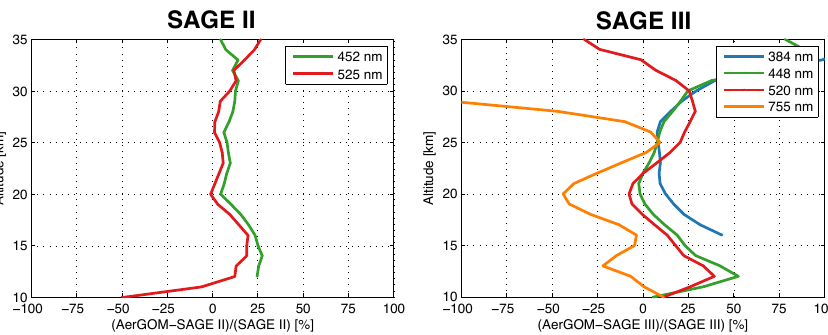
Figure 5. Relative difference of aerosol extinction comparisons between a modified AerGOM dataset using a different spectral law (poly- nomial of degree 1 in λ − 1 ) and SAGE II and SAGE III datasets at different wavelengths. These results show a better agreement between AerGOM and both SAGE instruments below 20km.